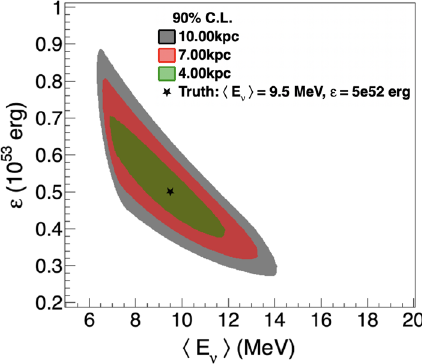
Fig. 16 Sensitivity regions generated in ( (cid:5) E ν (cid:6) ,ε) space (profiled over α ) for three different supernova distances (90% C.L.). SNOw- GLoBES assumes a transfer matrix made using MARLEY with a 20% Gaussian resolution on detected energy, and a step efficiency function with a 5 MeV detected energy threshold